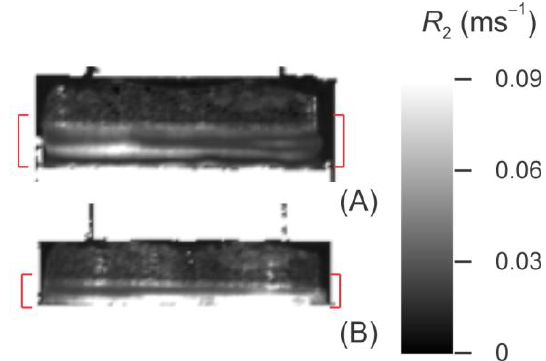
Figure 8. R maps of Sample 4. Metal and plastic components of the consolidometer, 2 which produce no MRI signal, have been masked out. The red brackets show the cartilage before ( A ) and after ( B ) compression, with the remaining signal arising from the supporting bone. A linear greylevel scale is used, with white corresponding to R to R = 2